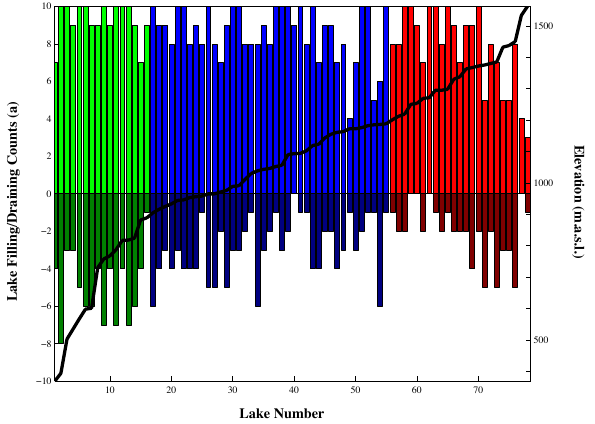
Fig. 3. Lake filling and rapid draining occurrence for individual Figure 3. Lake filling and rapid draining occurence for individual lake basins. The total 2 lake basins. The total number of years a lake filled appears as pos- number of years a lake filled appears as positive bar, colored according to its elevation 3 itive bar, colored according to its elevation group (Fig. 1). Total group (Figure 1). Total years where a rapid drainage event occurred appear as negative 4 years where a rapid drainage event occurred appear as negative bars. Lakes are sorted by increasing elevation, which is plotted on bars. Lakes are sorted by increasing elevation which is plotted on the right y-axis as a 5 the right y axis as a black line. Both lake and rapid drainage oc- black line. Both lake and rapid drainage occurrence generally decrease with increasing 6 currence generally decrease with increasing elevation; however, the largest high-elevation lakes tend to drain rapidly, despite increased elevation; however, the largest high elevation lakes tend to drain rapidly, despite 7 ice increased ice thickness. 8